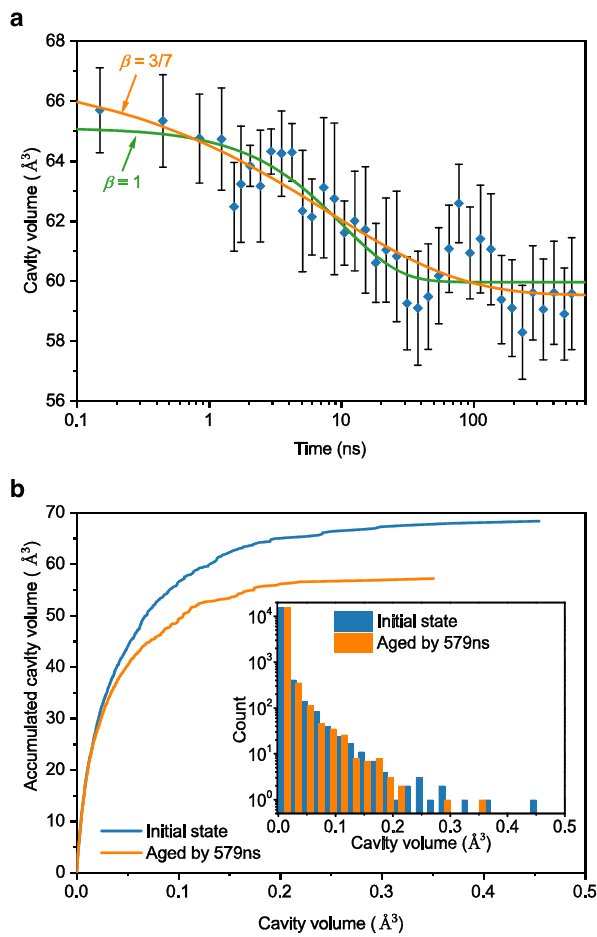
Fig. 4 | Structural evolution during accelerated aging. a Total cavity volume decayinMDmodeledZr 70 Cu 30 MGinacceleratedagingat300K.Thesolidorange and green curves show the fi tting of KWW function with β =3 = 7 and β =1, respec- tively. Error bars represent standard deviations. b Accumulated distribution of cavity volume with respect to cavity volume before and after aging. Inset shows cavity volume distribution. The evolution of cavity volume may be responsible for the underlying structural basis of physical aging with β =3 = 7 in